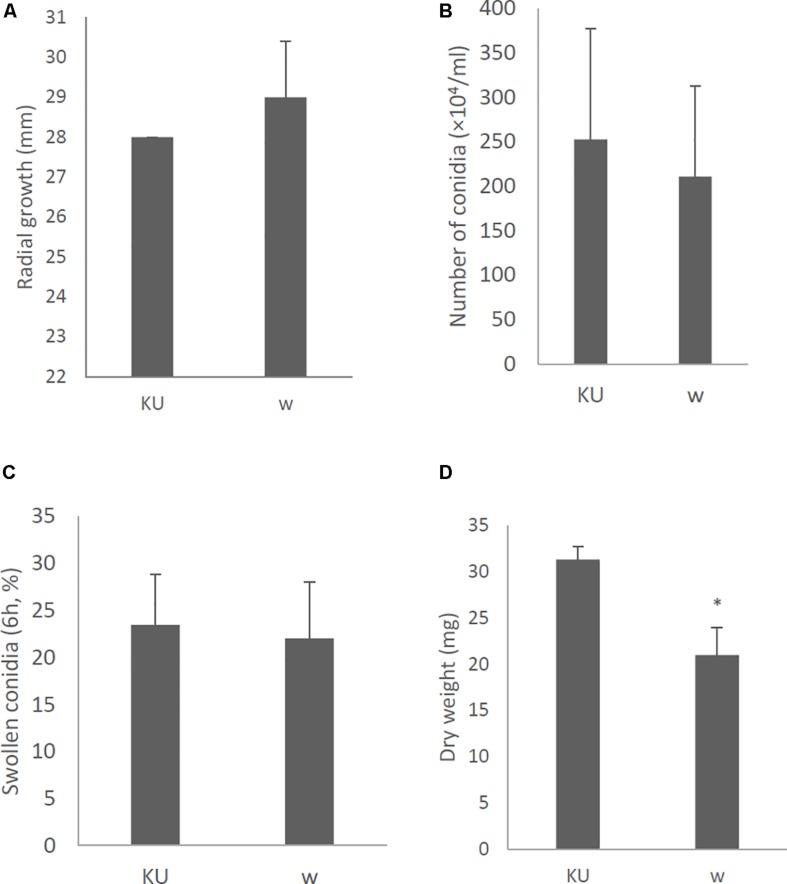
Morphological comparisons of the whole-virus infected KU strain and the native virus-free KU. (A) Radial growth of colonies. (B) The number of conidia formed by the strains at 24 h after starting point inoculation. (C) Percentages of swelling (6 h, D conidia of the strains). (D) Mycelial growth. Growth was quantified by measuring dry weights of mycelia at 24 h after starting incubation of conidia. Data are presented as mean ± SD of three independent experiments. ∗P < 0.05, by two-tailed Student’s t-test.